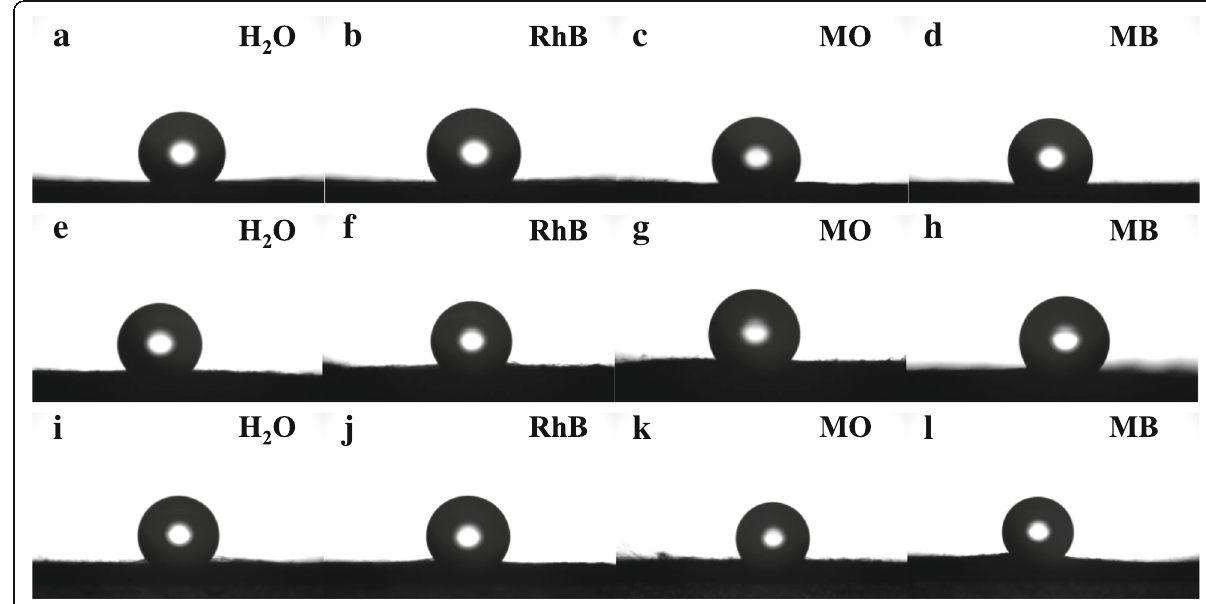
Fig. 9 The optical images of static contact angle for a – d TiO 2 /PVDF fibers, e – h Cu 0.1, and i – l Cu